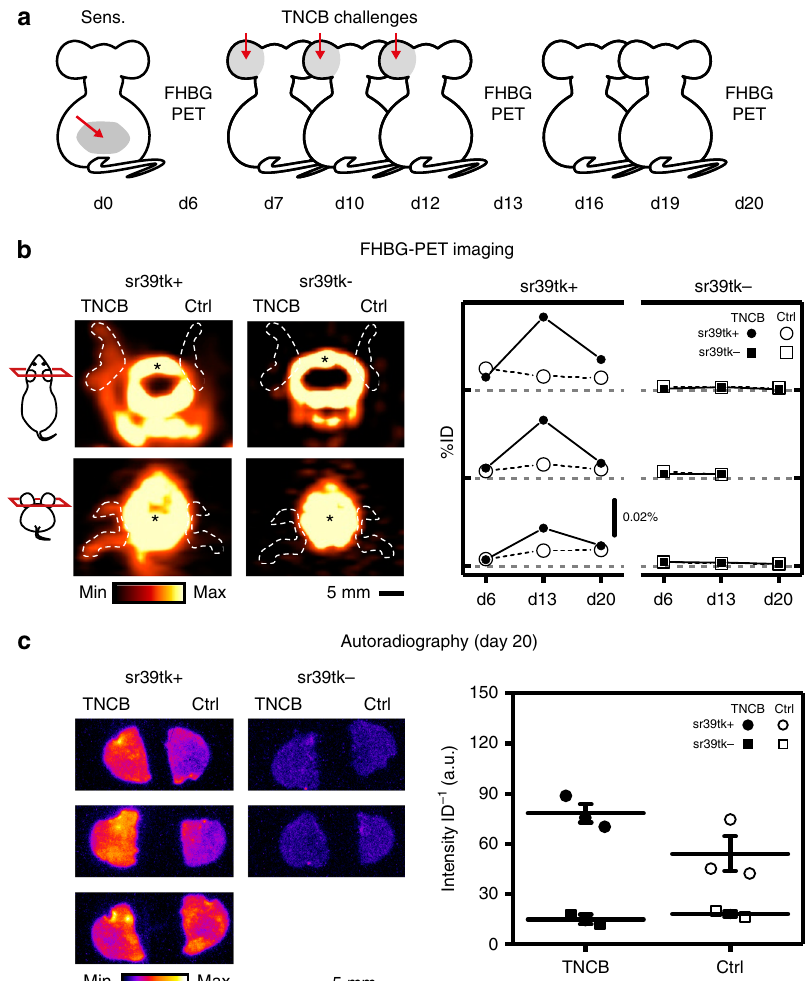
Fig. 4 Longitudinal tracking of T-cell homing in CD4/sr39tk mice during cutaneous DTHR. a At day 0 (d0), four CD4/sr39tk mice (sr39tk+; genotype: CD4-Cre[tg/+],R26[sr39tk/+]) and three litter-matched Cre-negative control animals (sr39tk − ; genotype: CD4-Cre[+/+],R26[sr39tk/+]) were sensitized by cutaneous application of 5% TNCB to the abdomen ( red arrow at day d0). Cutaneous DTHR on the left ear was elicited by three repetitive challenges with 1% TNCB on day 7, 10, 12 ( red arrows ). Animals were analyzed by [ 18 F]FHBG-PET on day 6, 13 and 20, and killed on day 20 for ex vivo analysis of [ 18 F]FHBG uptake. One sr39tk+ animal developed an infection of the TNCB-challenged ear and was excluded from analysis. One sr39tk − animal died on day 20. b Left , representative [ 18 F]FHBG-PET images of the head region of a sr39tk+ and a sr39tk − mouse recorded on day 13. Ear boundaries are outlined by dashed lines; left ears had been challenged with TNCB, whereas right ears had not been challenged (Ctrl). Images were normalized to injected tracer dose. Pictograms on the left show orientation and relative position of the image plane ( red ). Nonspeci fi c tracer accumulation was detected in bone (*). Right , longitudinal PET imaging showing the time course of [ 18 F]FHBG uptake into TNCB-challenged ears (TNCB, black symbols) and non-challenged ears (Ctrl, white symbols) of individual sr39tk+ (left) and sr39tk − ( right ) mice. Values were normalized to injected tracer dose (ID); grey dashed lines represent 0% ID for each animal. c Left , [ 18 F]FHBG autoradiography of the ears from three sr39tk+ and two sr39tk − mice at the end of the study on day 20; left ears had been challenged with TNCB; right ears had not been challenged (Ctrl). Right , quanti fi cation of [ 18 F]FHBG uptake by autoradiography of the TNCB-challenged ears (TNCB, black symbols ) and non-challenged ears (Ctrl, white symbols ). Intensity (arbitrary units, a.u.) was background-corrected and normalized to injected tracer dose (ID); data points indicate individual animals; bars represent mean ± s.e.m. See also Supplementary Fig.